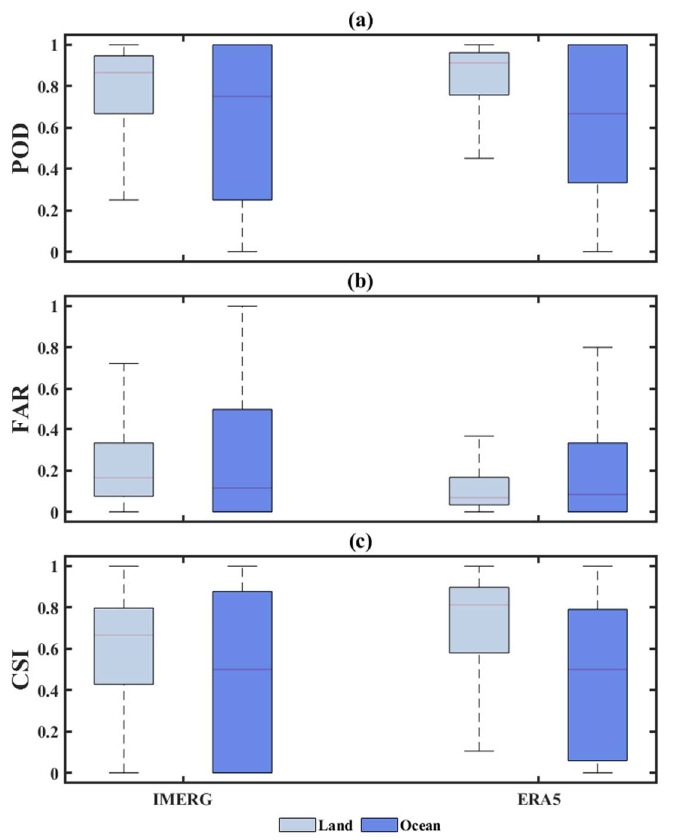
Figure 2. Boxplots of POD, FAR, and CSI metrics for ERA5 and IMERG (2000–2007) over land and ocean. ( a ) POD. ( b ) FAR. ( c ) CSI.